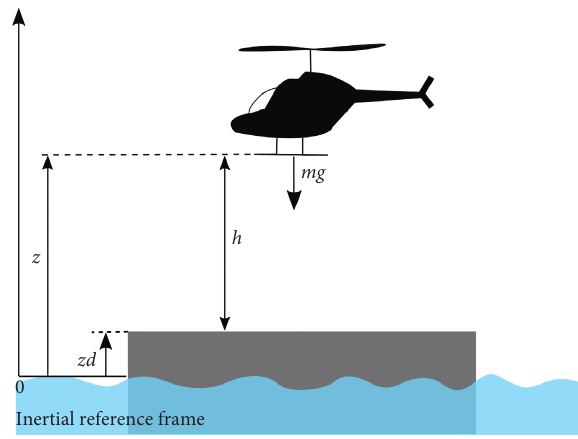
Figure 1: The VTOL-UAV landing task over a vertically moving